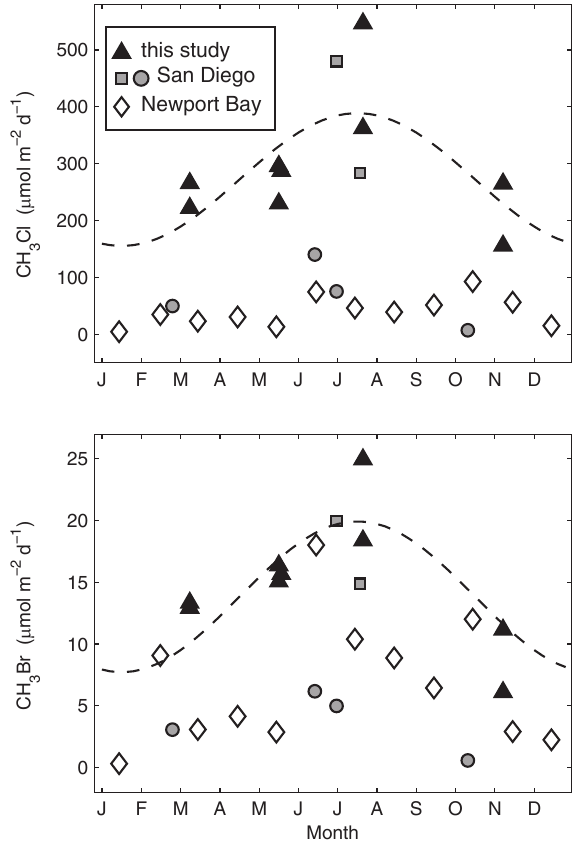
Figure 3. Comparison of B. maritima methyl halide emissions from three coastal salt marshes. This study (black triangles) shows diel averages. The San Diego, California sites show diel averages (gray squares) at two B. maritima sites and daytime fluxes (gray circles) at mixed B. maritima/Salicornia bigelovii sites (Rhew et al., 2000, 2002). The Upper Newport Bay, California, sites (white diamonds) show daytime fluxes of monospecific B. maritima sites (Manley et al., 2006). The dashed line is a sinusoidal curve fit to the Texas